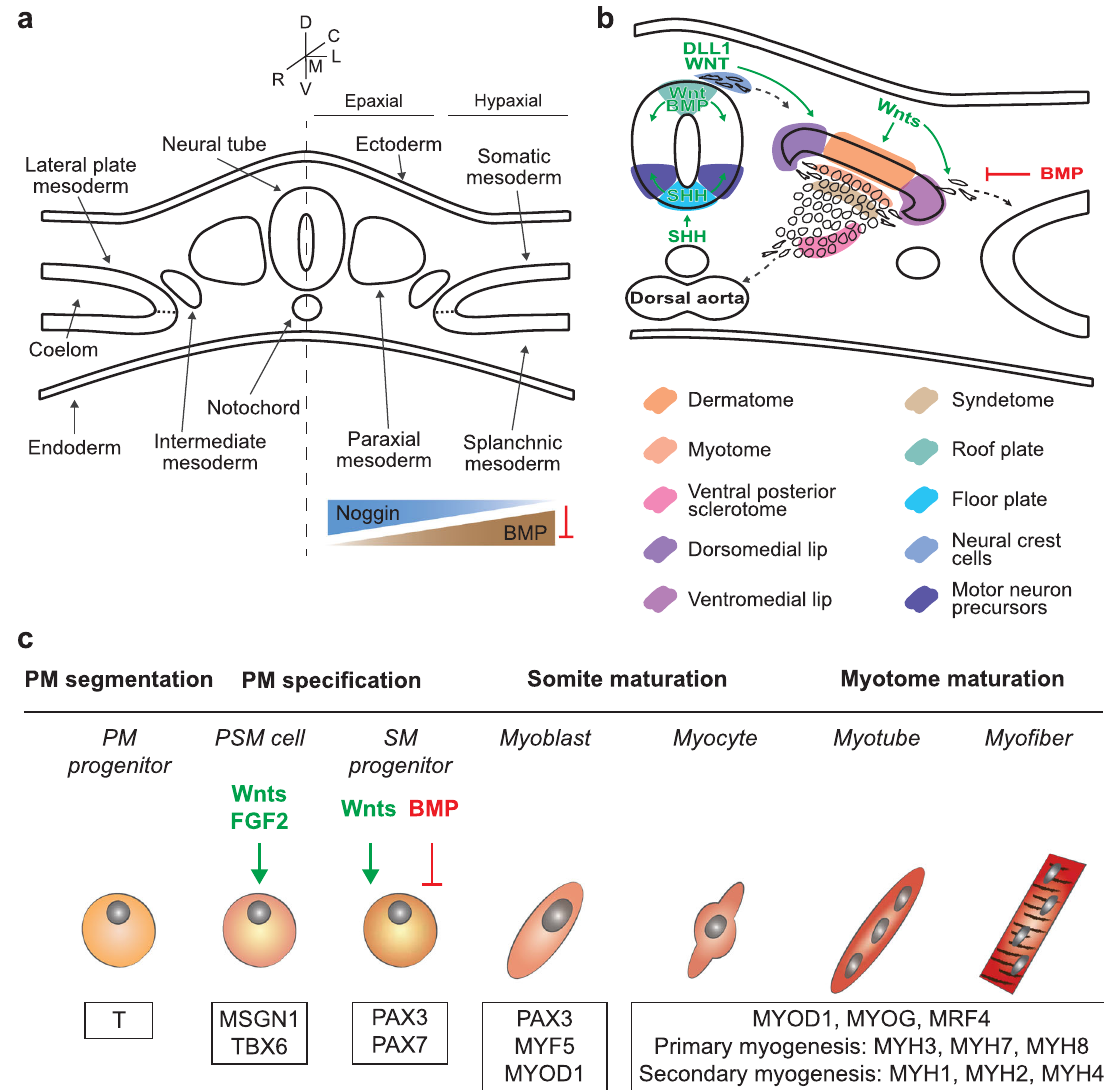
Fig. 1 Skeletal muscle development. a Scheme of the mesoderm patterning along the mediolateral axis by gradients of speci fi c signaling molecules, as Noggin and BMP. D dorsal, L lateral, M medial, V ventral, R rostral, C caudal. b Color-coded scheme of the differentiating somites and the surrounding structures during gastrulation and neurulation. Signaling molecules are indicated in green if acting as pro-differentiative actors, in red if they inhibit the differentiation process; dashed lines show paths of cell migration. c Representation of the differentiation process of skeletal muscle cells of the axial and limb muscles, starting from the paraxial mesoderm (PM) progenitors. Marker genes are shown in the bottom boxes, while the main signaling molecules are indicated in green if acting as pro-differentiative actors, in red if they inhibit the differentiation process. PSM presomitic mesoderm, SM skeletal muscle. Schemes adapted and modi fi ed from 35,206